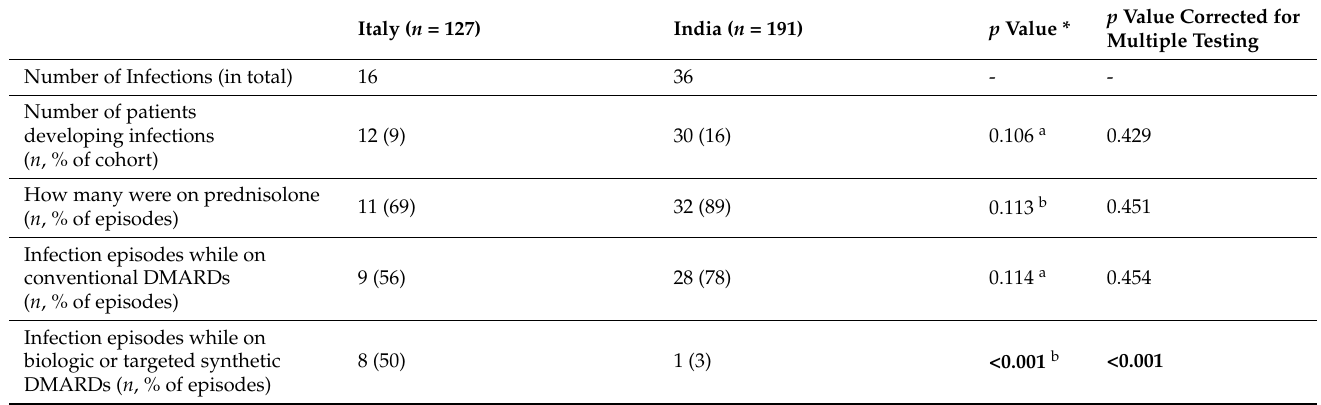
Table 2. Infections requiring hospitalization or resulting in death.